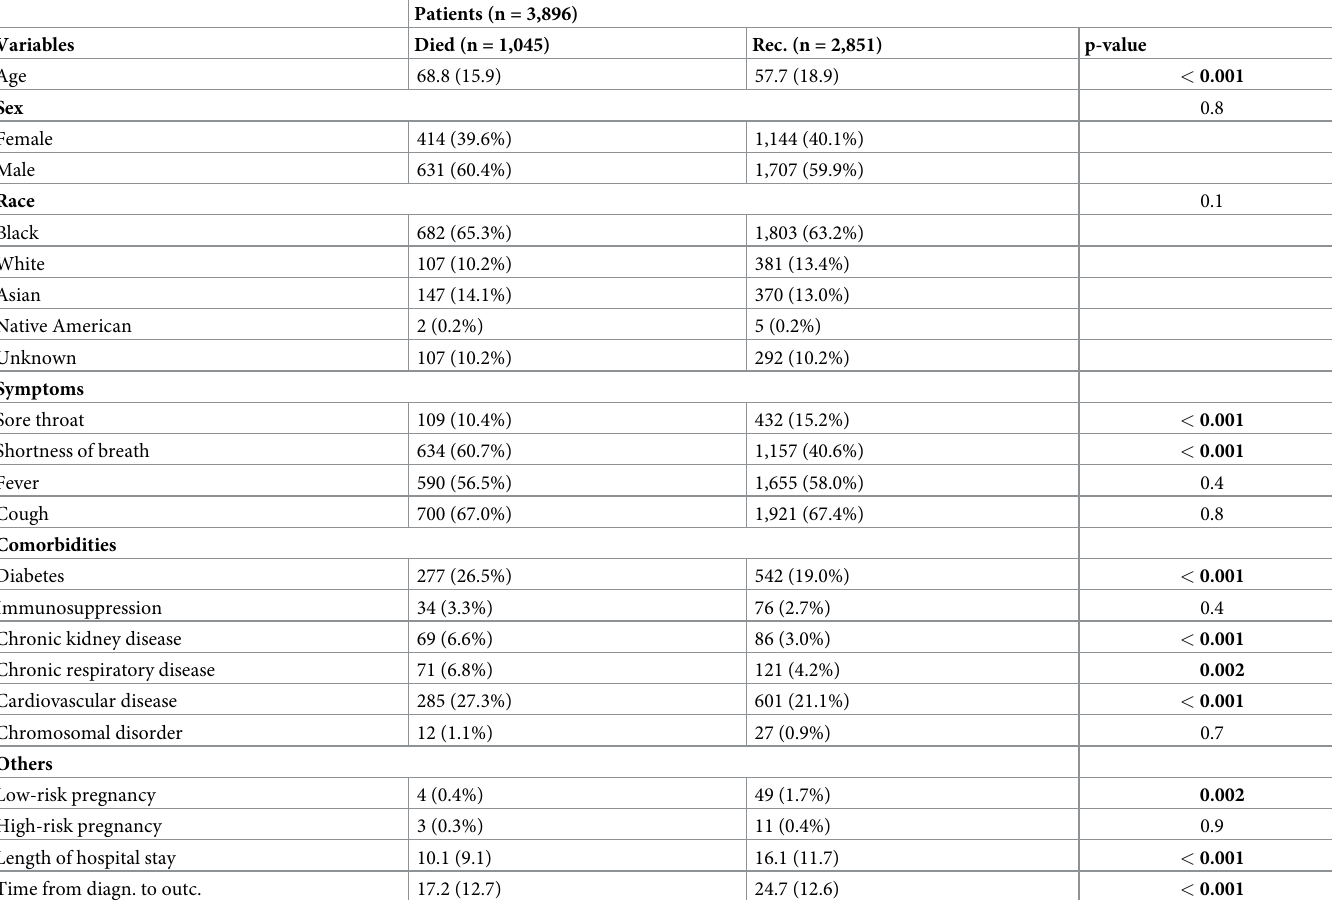
Table 1. An overview of the dataset used in this study, according to the definitive outcome of hospitalized COVID-19